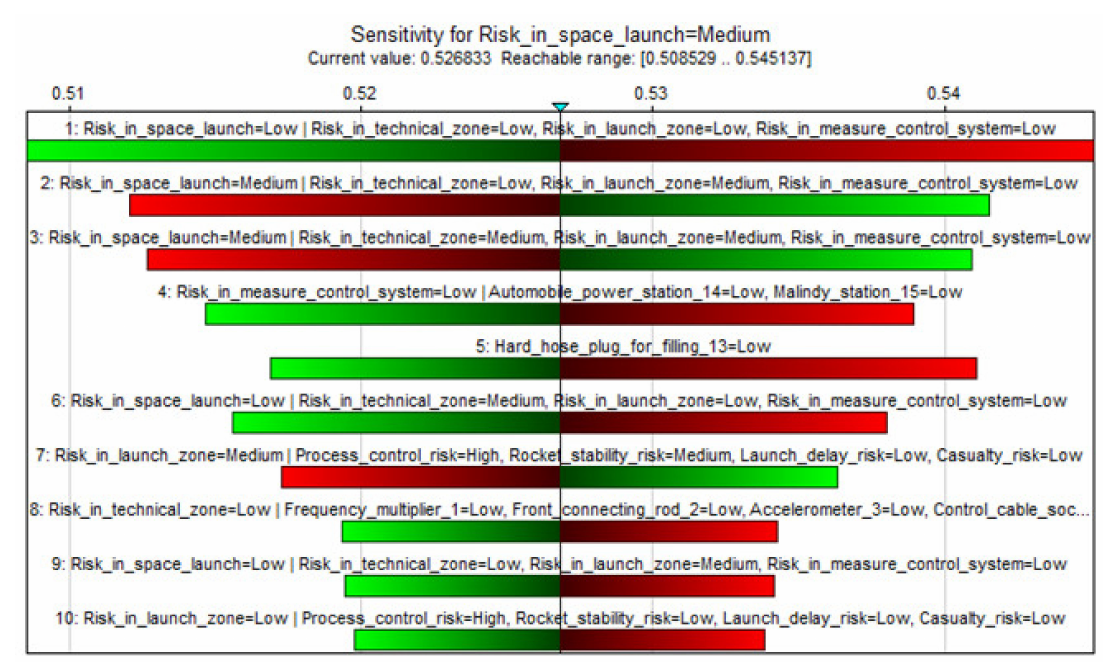
Figure 10. Sensitivity ranking for the medium risk in a space